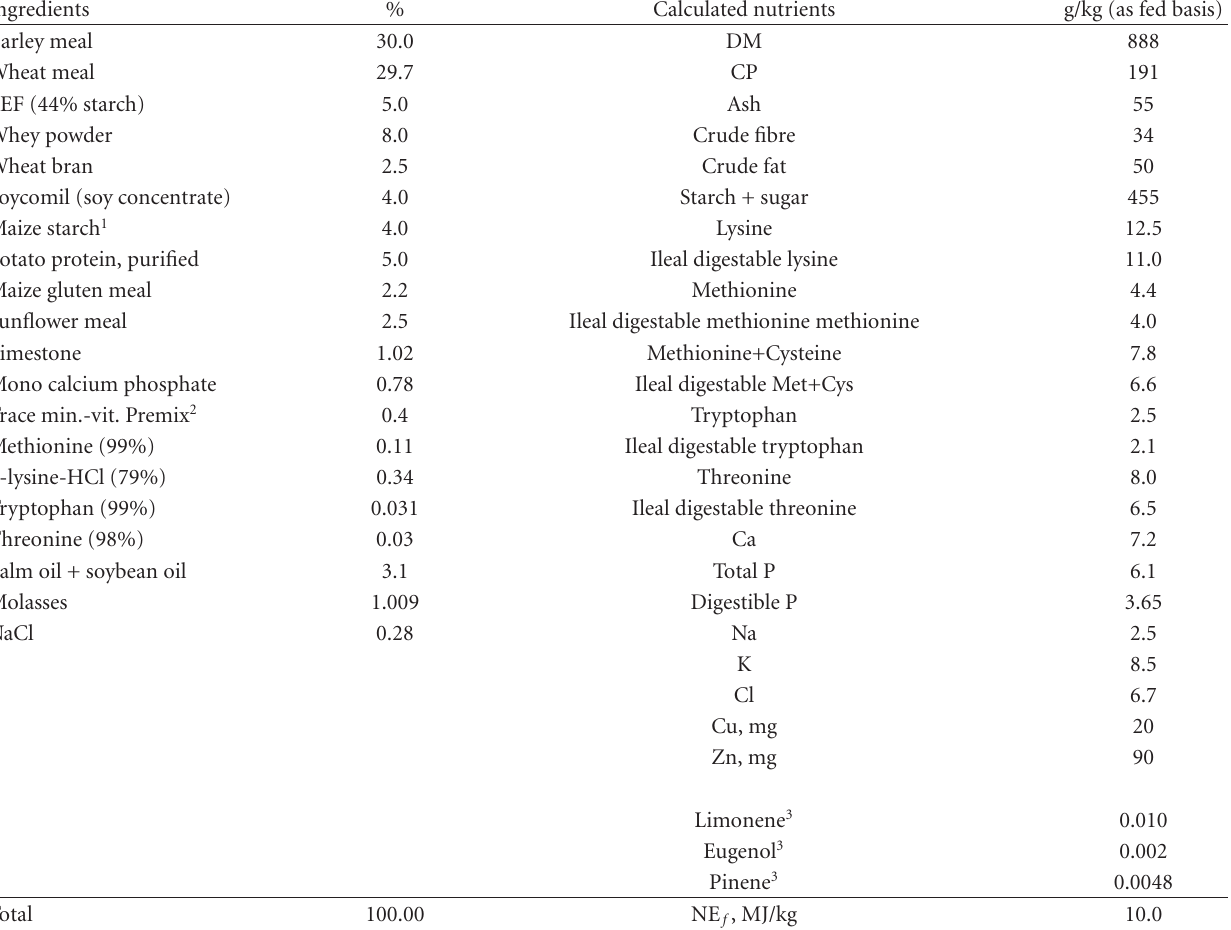
Table 1: Composition of the control and experimental starter